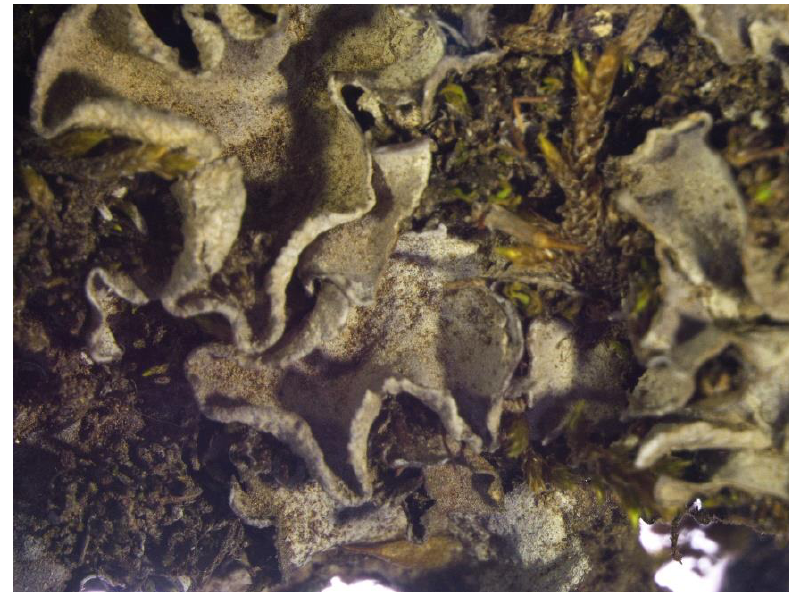
Figure 1. Morphological structure of P. rufescens .